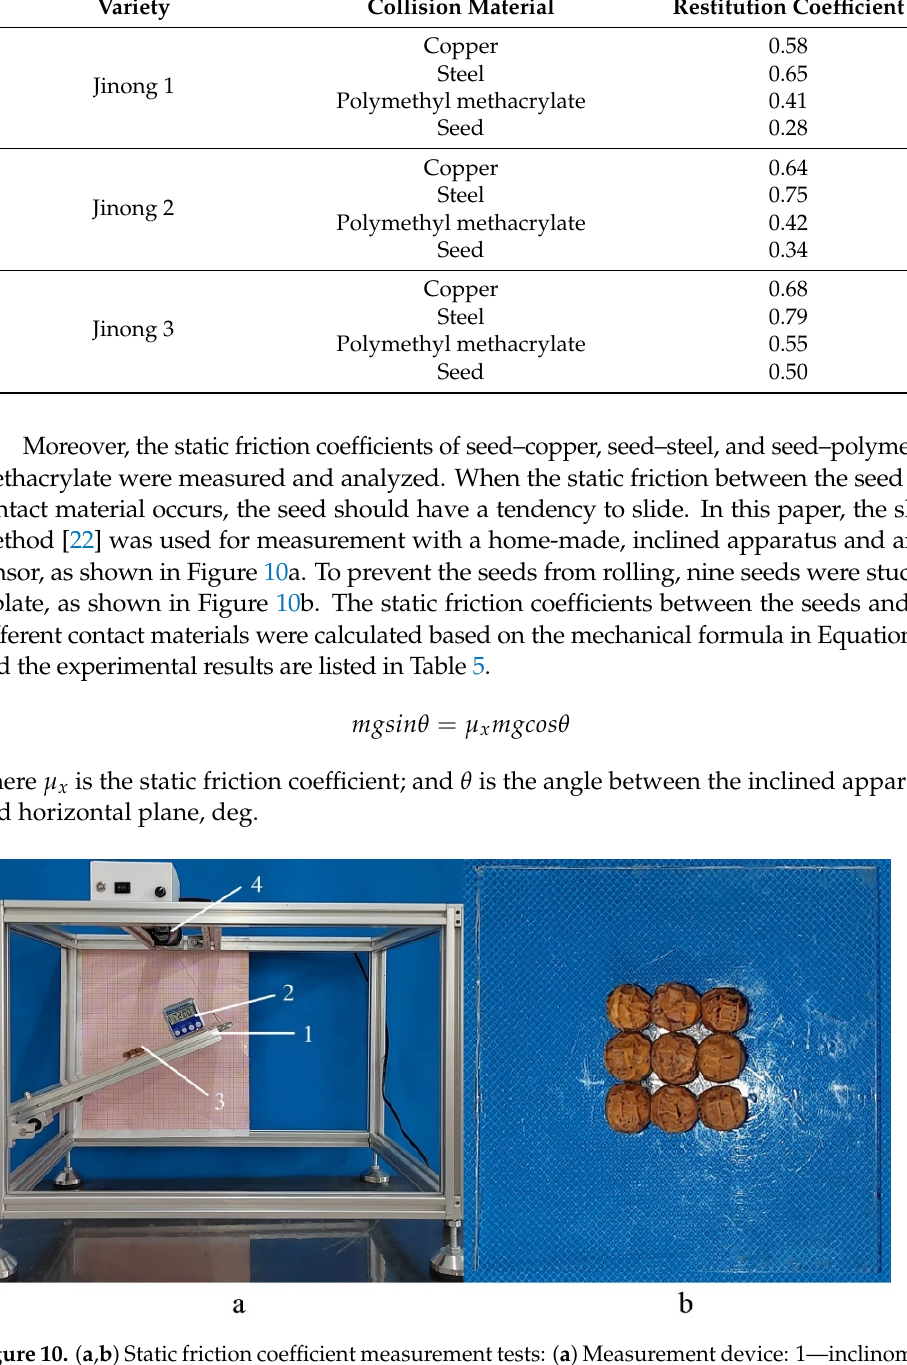
Figure 10. ( a , b ) Static friction coefficient measurement tests: ( a ) Measurement device: 1—inclinometer, 2—angle transducer, 3—seed plate, 4—electromotor; ( b ) Seed plate. Table 5. Static friction coefficient for different varieties of Cyperus esculentus